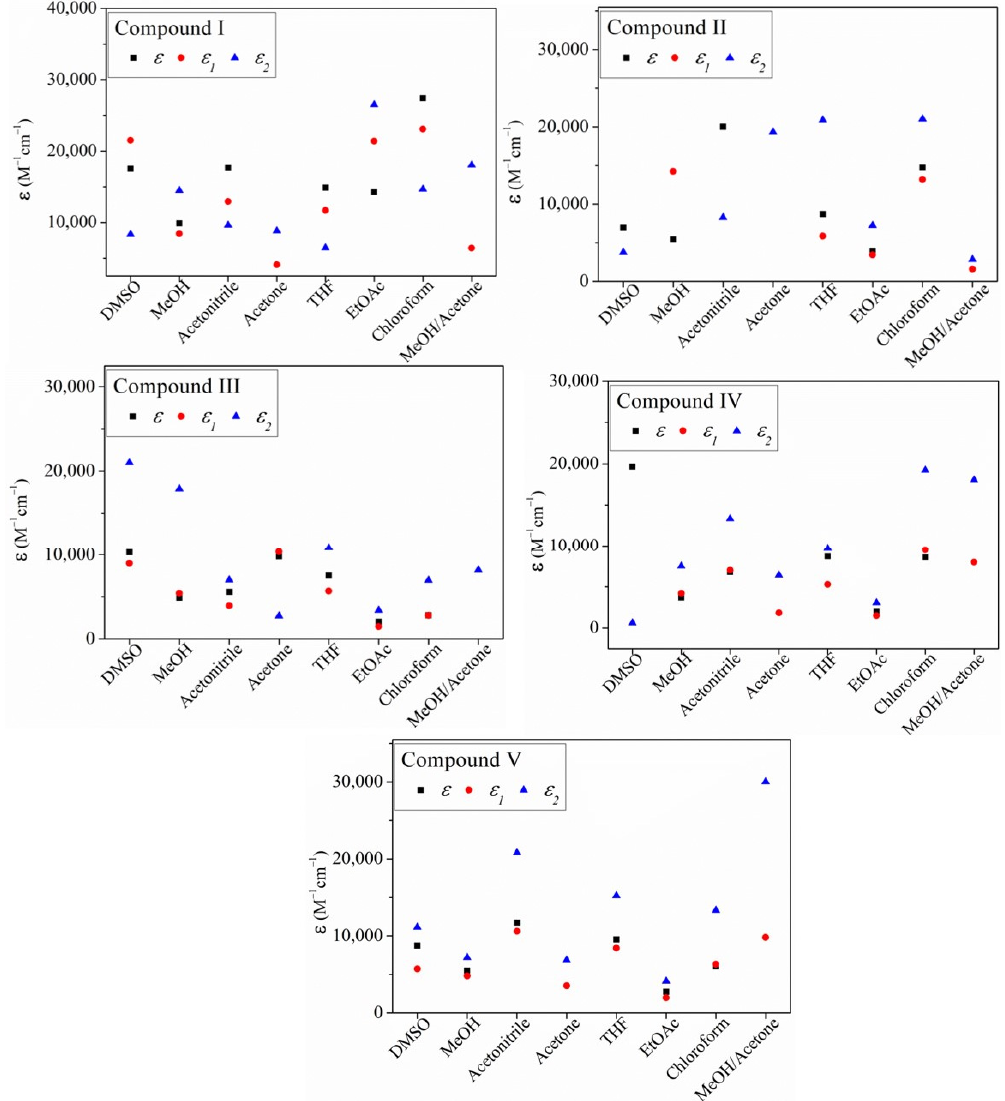
Figure 2. Molar extinction coefficient of the compounds I and II , III , IV , V and in solvents ( 1 ) DMSO, ( 2 ) MeOH, ( 3 ) AcCN, ( 4 ) acetone, ( 5 ) THF, ( 6 ) EtOAc, ( 7 ) CHCl 3 , and ( 8 ) MeOH:acetone (70:30). Concentration of 0.001 mM.